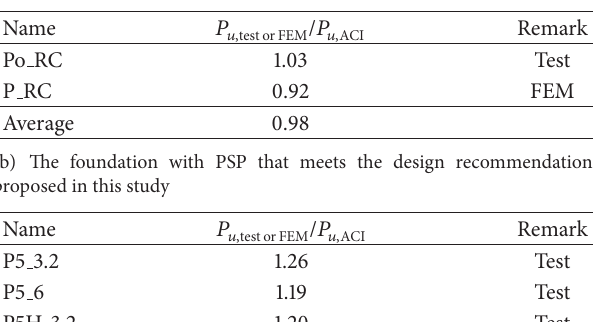
Table 3: Comparison with ACI design